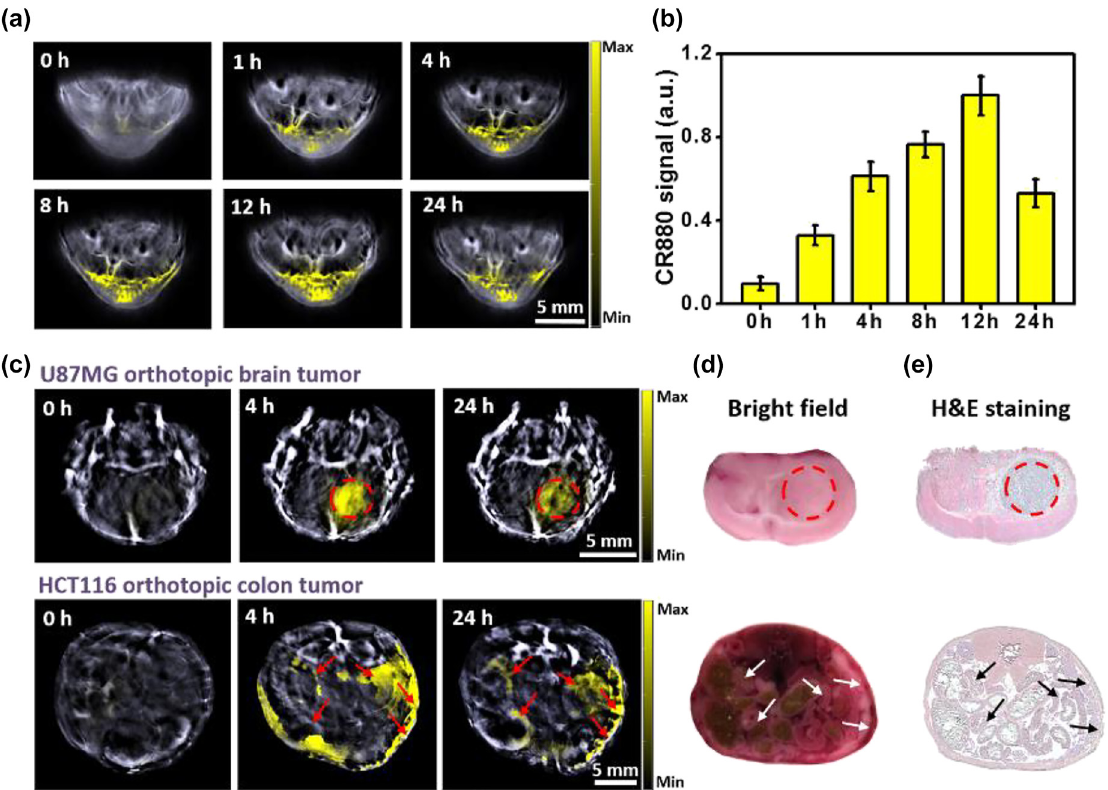
Figure 3: Optoacoustic imaging with CR880-NPs in vivo . (a) Representative unmixed MSOT images of 4T1 subcutaneous tumor models intravenously injected with 100 μ L of CR880-NPs (0.3 mM), ( n = 5). The unmixed CR880 signal is indicated by the yellow color in the tumor region. (b) Quantification of panel (a): CR880-NPs concentration in the tumor region measured over time. (c) Representative unmixed MSOT image of U87MG-bearing orthotopic glioblastoma and HCT116-bearing orthotopic colon tumor intravenously injected with 100 μ L of CR880-NPs (0.3 mM) ( n = 3). (d, e) Bright field imaging and H & E staining of a representative brain tumor (top) and colon tumor slices